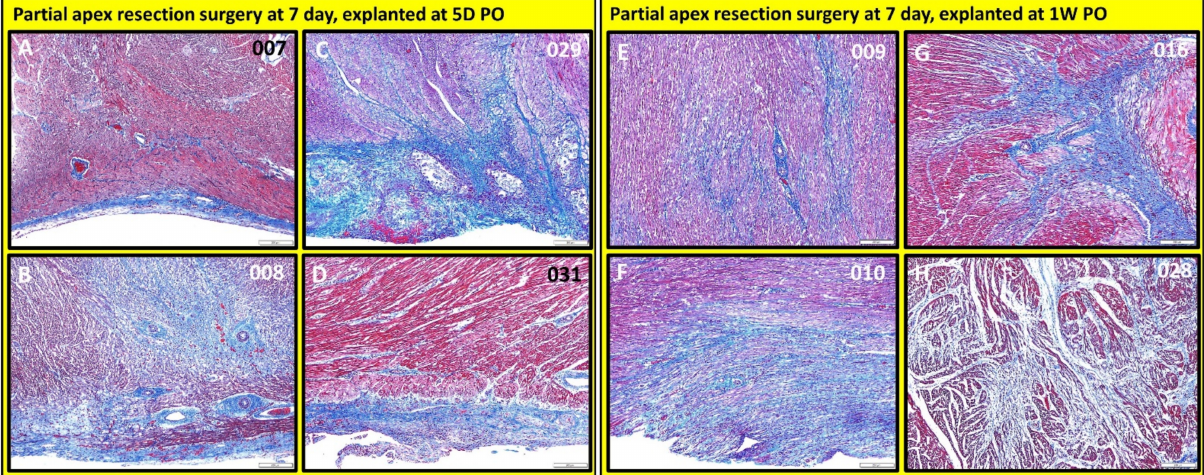
Figure 14. Partial apex resection surgery at seven days and heart explants at 5D PO and 1W PO- Masson’s Trichrome histology of seven-day surgery heart explants obtained five days post-operation (5D PO): ( A ) Seven-day surgery heart from piglet #007. ( B ) Seven-day surgery heart from piglet #008. ( C ) Seven-day surgery heart from piglet #029. ( D ) Seven-day surgery heart from piglet #031. Masson’s Trichrome histology of seven-day surgery heart explants obtained one week post-operation (1W PO): ( E ) Seven-day surgery heart from piglet #009. ( F ) Seven-day surgery heart from piglet #010. ( G ) Seven-day surgery heart from piglet #016. ( H ) Seven-day surgery heart from piglet #028. Histological images were taken at 4 × magnification (Scale bar = 200 µ m). Masson’s Trichrome: red–muscle;